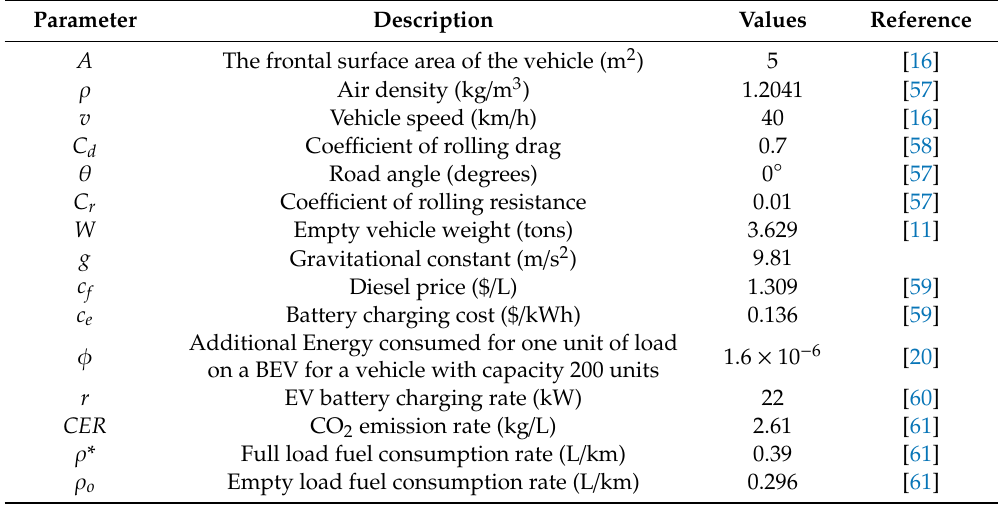
Table 2. Parameter values used for estimating energy consumption and emission